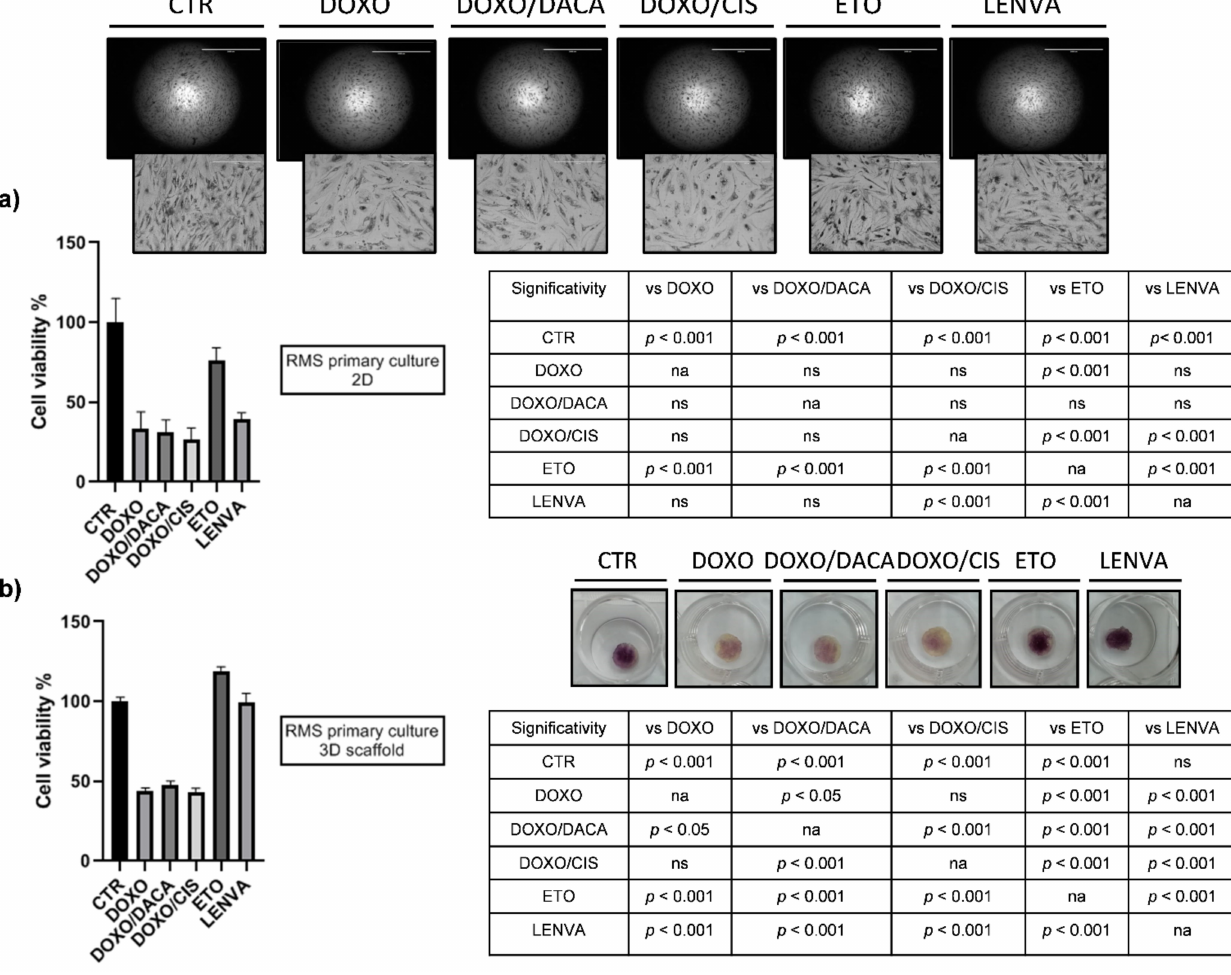
Figure 7. Chemobiogram analysis on ( a ) 2D (2 × magnification, 2000 µ m scale bar; 10 × magnification, 400 µ m scale bar) and ( b ) 3D patient-derived RMS primary culture. RMS primary cells were exposed to DOXO, DOXO/DACA, DOXO/CIS, ETO, and LENVA. Significant differences among treatments were accepted for p <